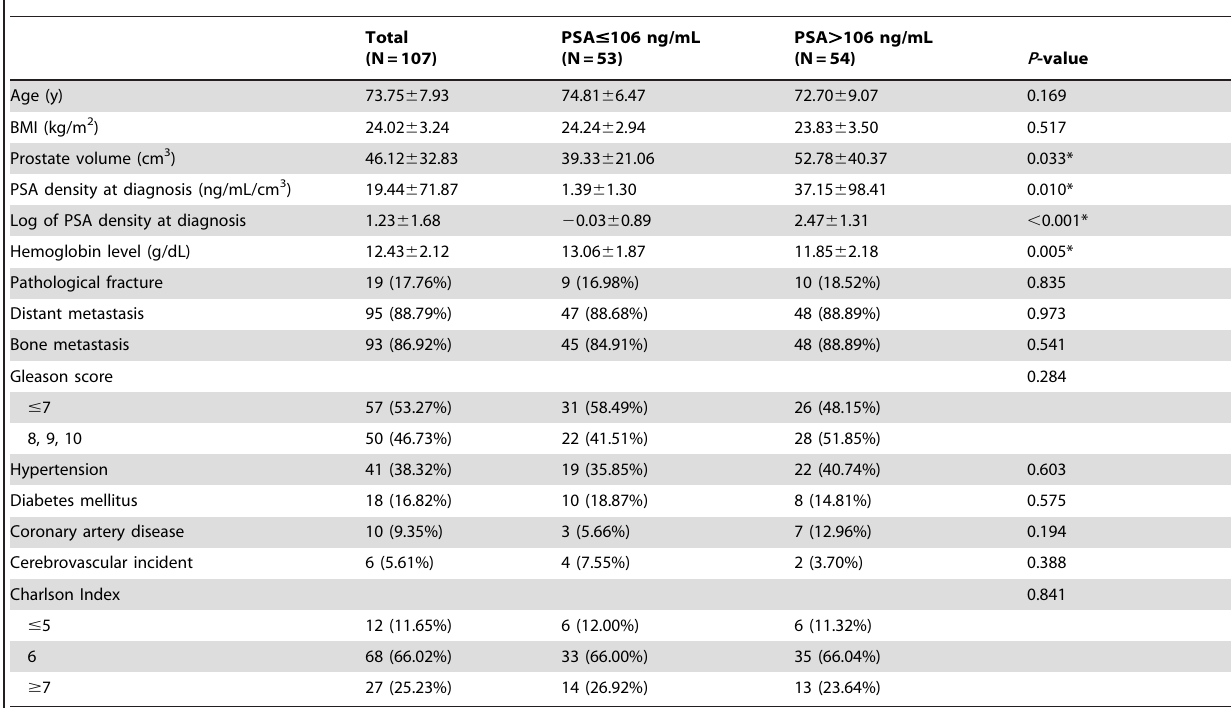
Table 1. Study variables at the time of diagnosis and their relationship to initial PSA levels a .